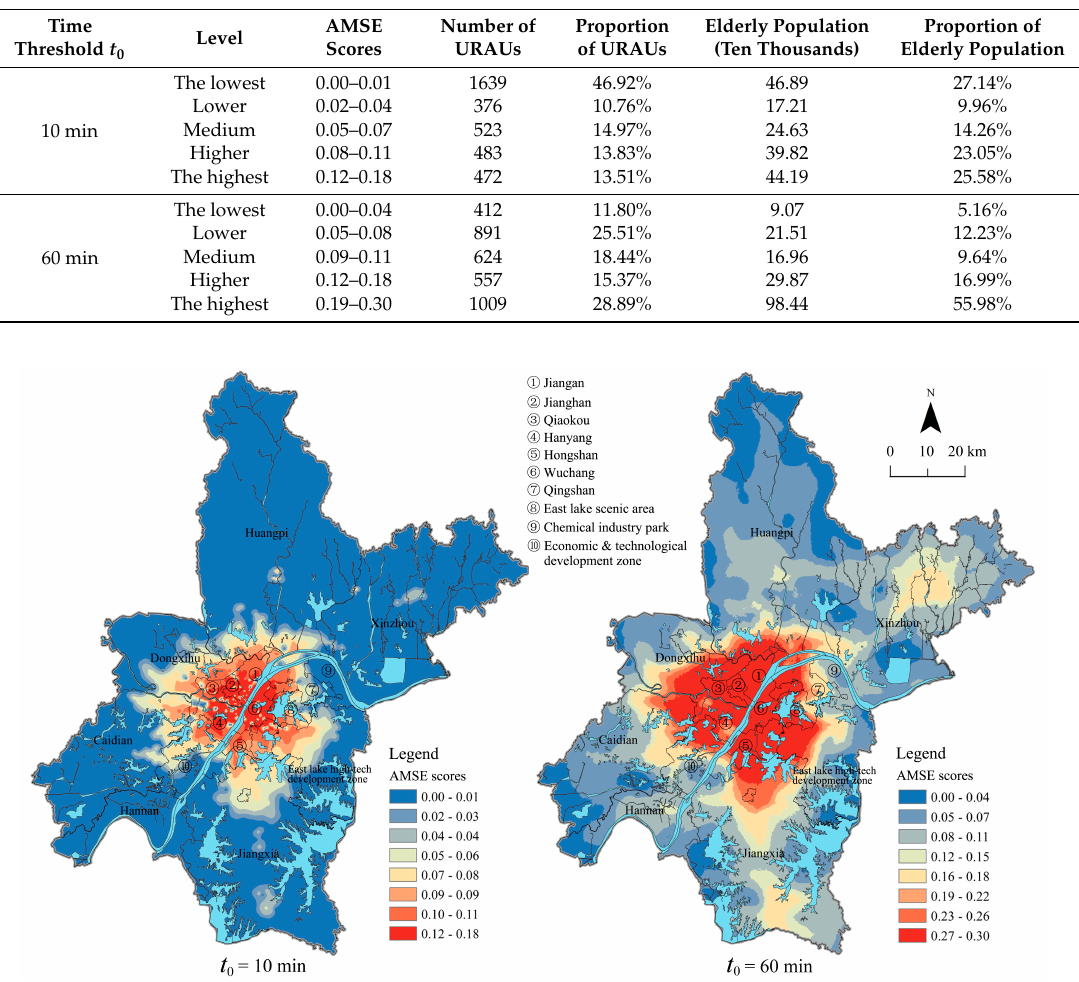
Figure 4. Spatial AMSE scores for two different threshold travel times. Int. J. Environ. Res. Public Health 2018 , 15 , x FOR PEER REVIEW